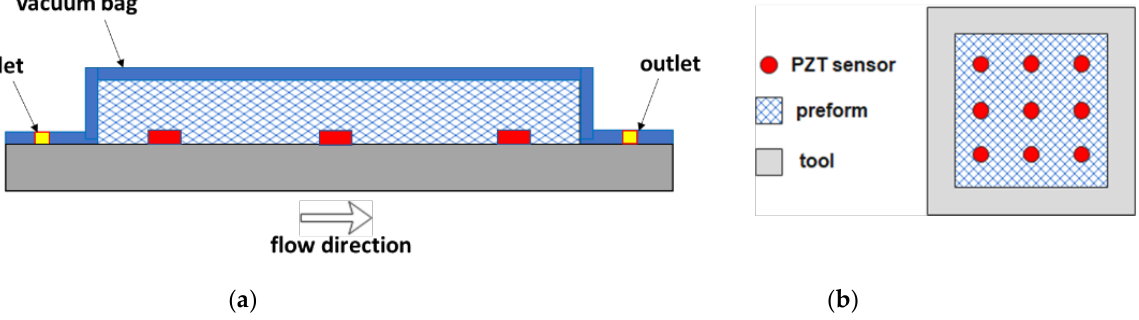
Figure 8. ( a ) Experimental set-up and ( b ) sketched cross-section of PZT sensors-based flow front monitoring (adapted from Liu et al. [78]). monitoring (adapted from Liu et al.